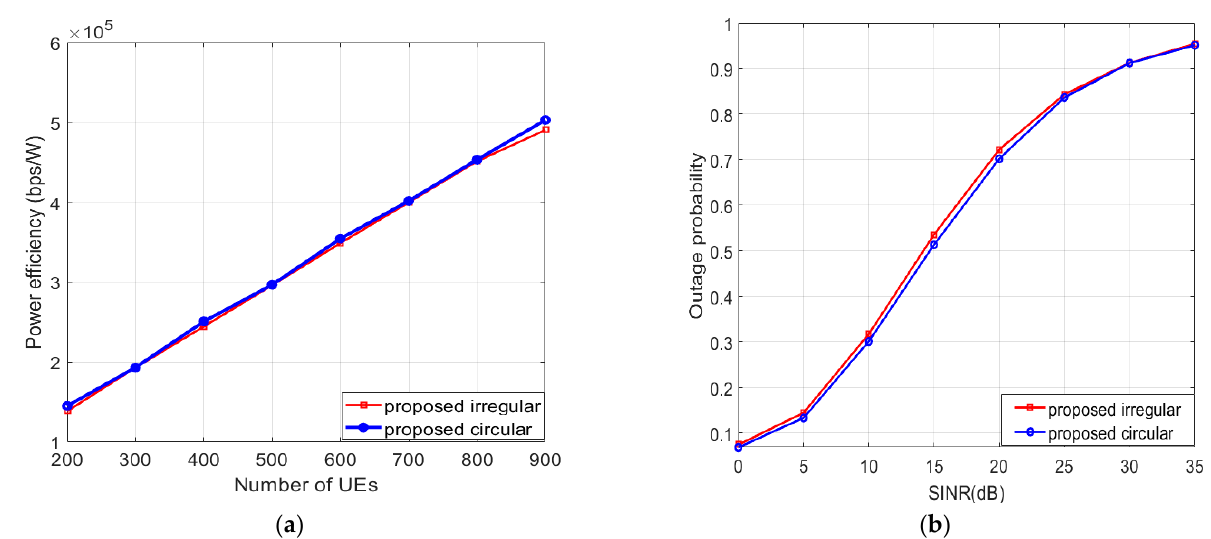
Figure 8. For the case of the circular center zone and the case of the center zone having the same irregular shape as the SC: ( a ) total data rate; ( b ) total power consumption.